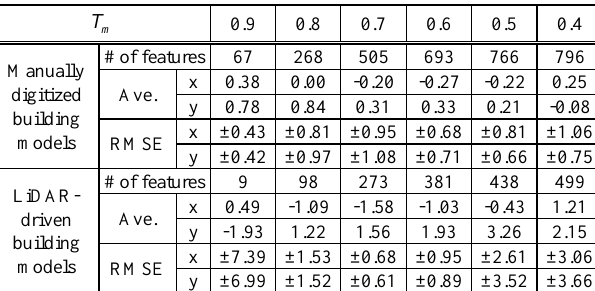
Table 3. Effects on